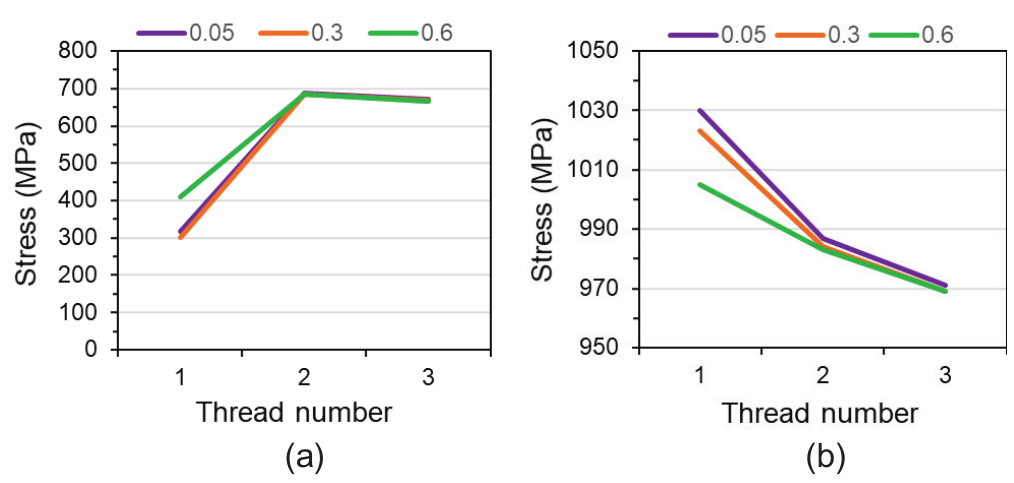
Figure 15. Variations in the maximum stress values at the root of the engaged threads ( a ) in the nut and ( b ) in the bolt as a result of change in the friction coefficient .